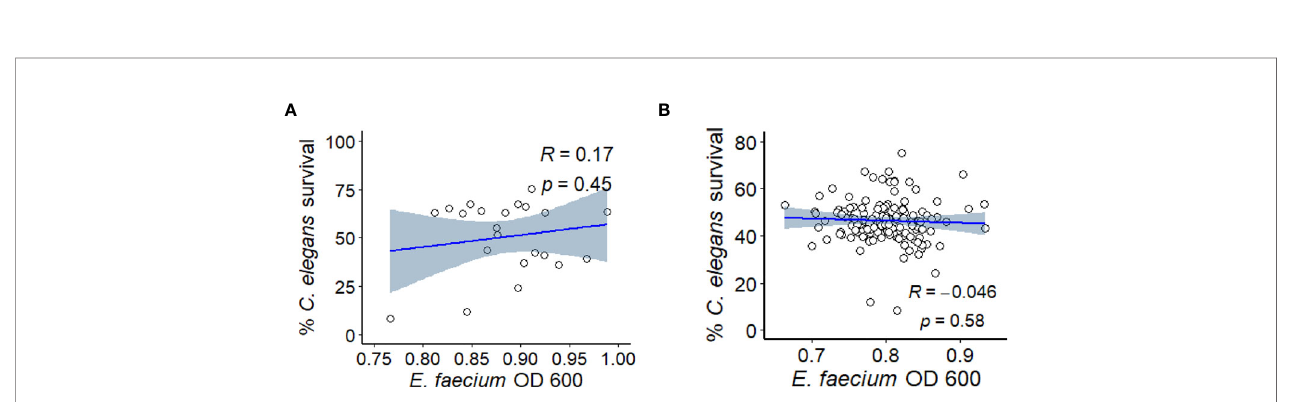
FIGURE 2 | E. faecium virulence in Enterococcus liquid killing assay does not depend upon bacterial growth. (A) Correlation plot of a subset of ~30 E. faecium strains ’ growth (OD 600, x-axis) against their virulence (based on C. elegans ’ survival, y-axis). (B) Correlation plot of ~120 of E. faecium strains ’ growth (OD 600, x- axis) against their virulence (based on C. elegans ’ survival, y-axis). Three biological replicates with ~80 worms/replicate were analyzed. The correlation plot was generated with R package ggplot2 (version